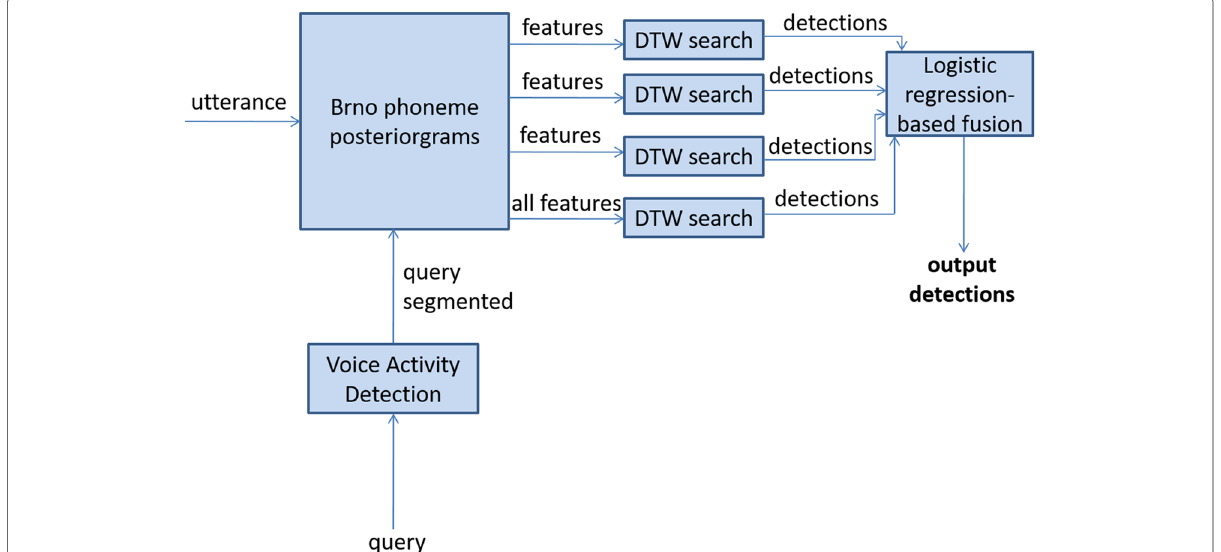
Fig. 5 F-SPL-IT-UC-Four phoneme recognizer+DTW-based fusion QbE STD system